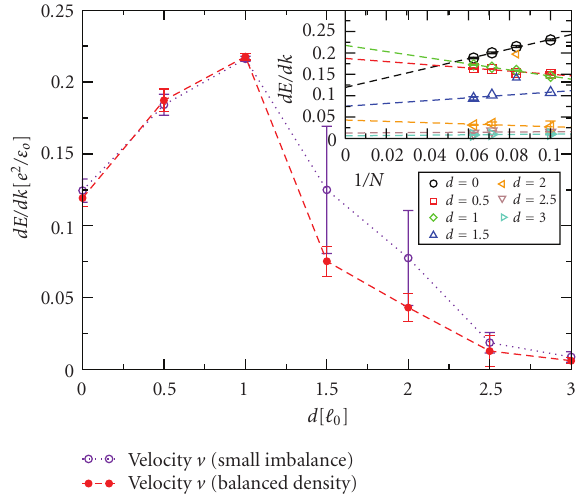
Figure 4: The velocity of the Goldstone mode depends strongly on the layer separation and peaks near d ∼ (cid:3) 0 . The velocity has significant finite-size e ff ects on the sphere, and therefore we extract an estimate of its value in the thermodynamic limit by extrapolating the finite-size values over the inverse system size (see inset). The main figure shows the resulting velocities for a density balanced bilayer, as well as for a slightly imbalanced system, as discussed in the main